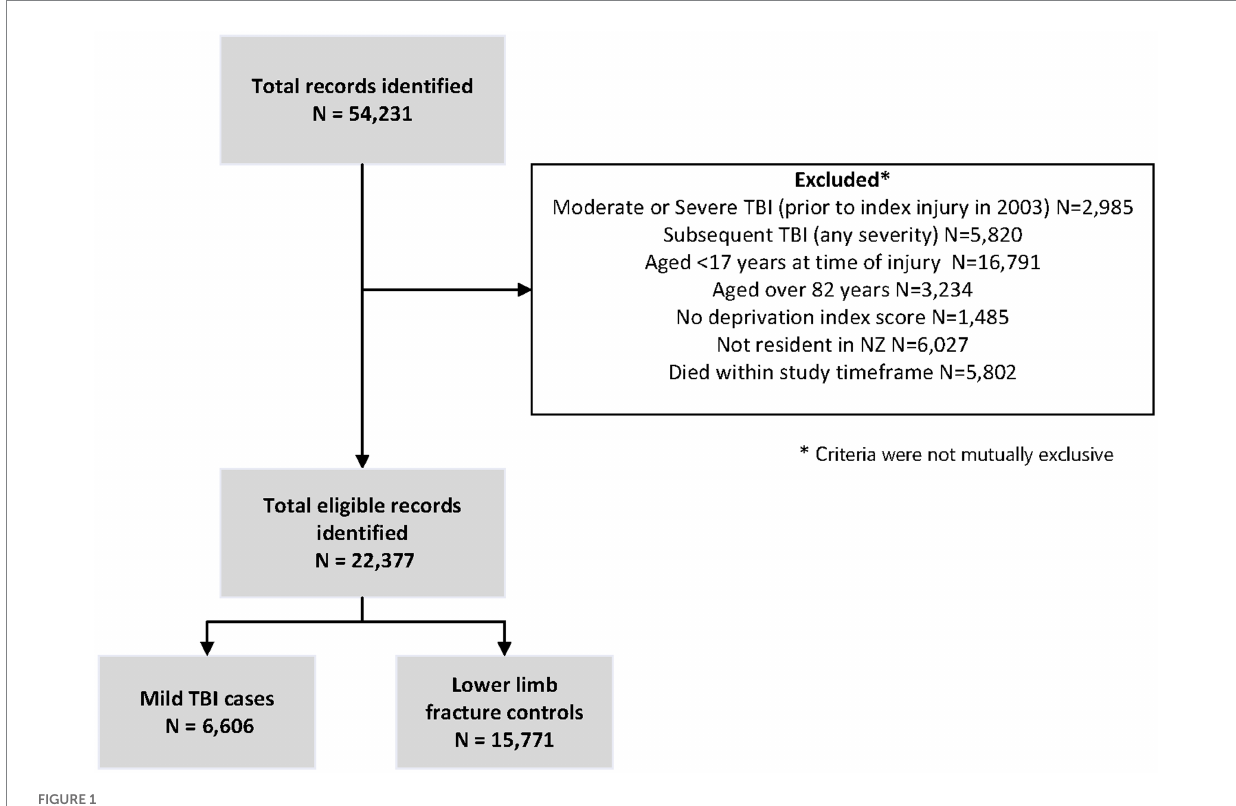
FIGURE 1 Selection of